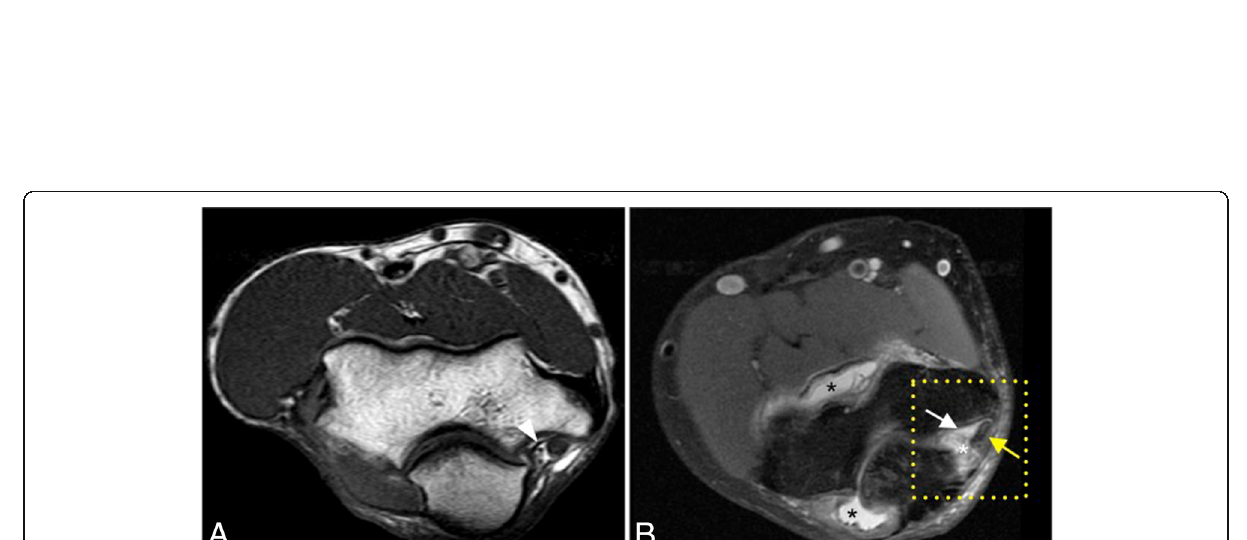
Fig. 17 A 25-year-old man with pain and medial instability after a fall on an outstretched hand. Axial T1-weighted MRI ( a ) showing the intact right posterior bundle of the medial collateral ligament complex of a healthy volunteer (white arrowhead). Axial FS PD-weighted MRI ( b ) showing an acute tear of the left posterior bundle of the medial collateral ligament complex (white arrow), inflammatory changes in the soft tissue of cubital tunnel (white asterisk), displacement and flattening of the ulnar nerve (yellow arrow), and joint effusion (black